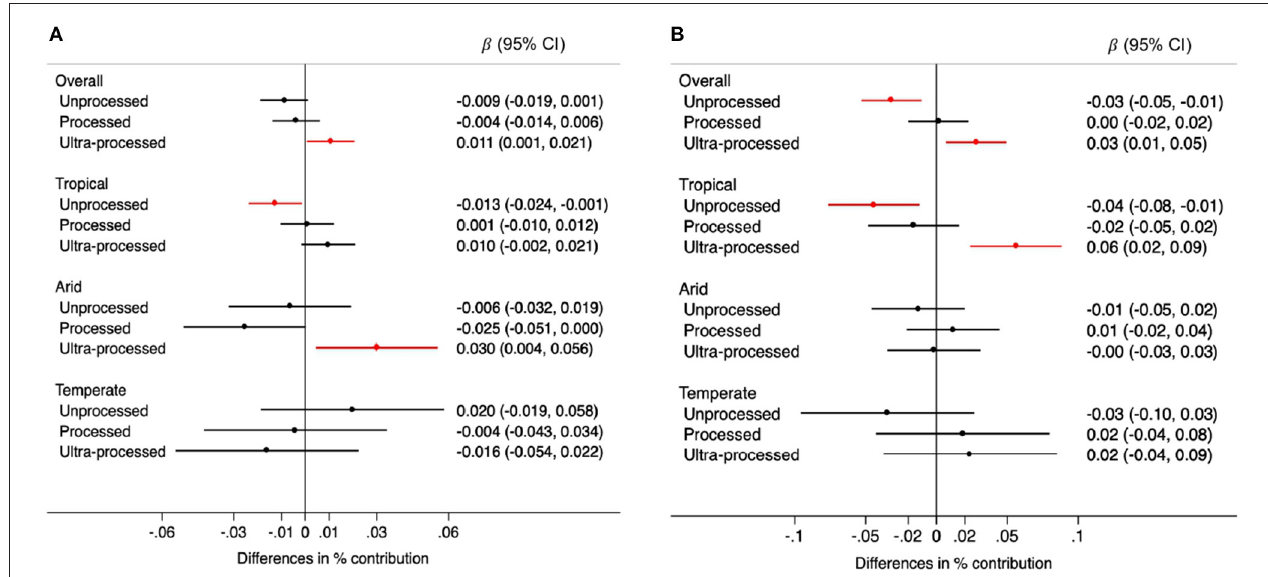
FIGURE 2 | Differences in the percentage (95% CIs) contribution of foods by processing level to the total energy intake for each 0.5mm annual decrease in rainfall (A) and for each 0.1 ◦ C annual increase in temperature (B) during the 5-year period prior to the survey, overall and by climate region. Values were obtained using multivariable multilevel linear regression models adjusted for climate region (overall models) sex, age group, educational level, and rainfall or temperature, as appropriate.